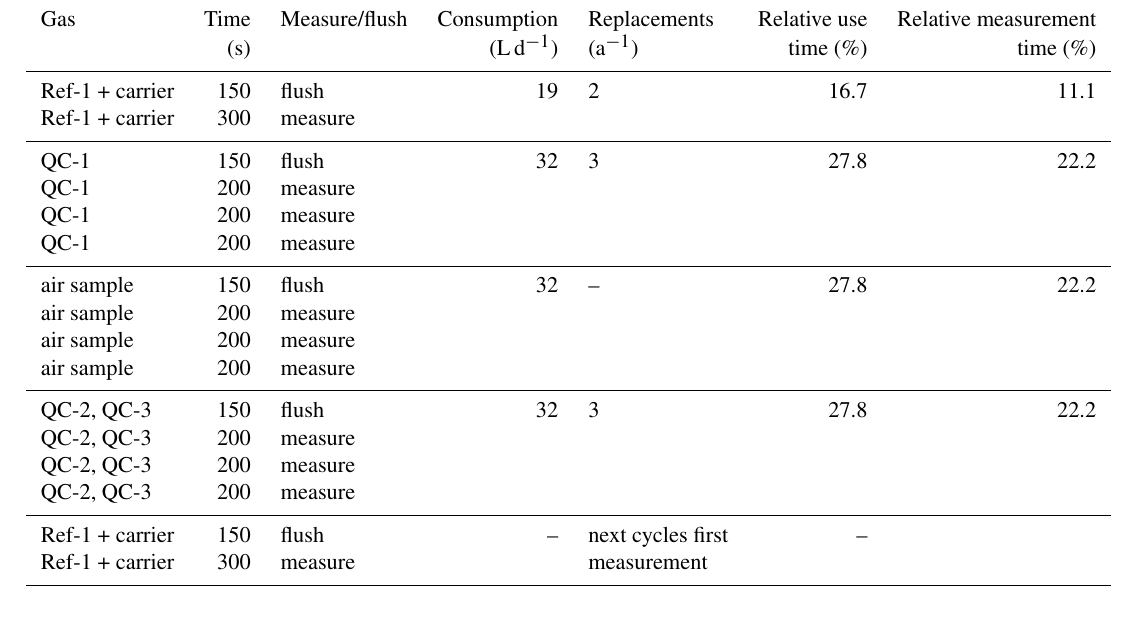
Table 2. Timing used for blocks in measurement sequence, resulting gas consumptions, resulting requirements for cylinder replacements per year and relative time each gas was measured.